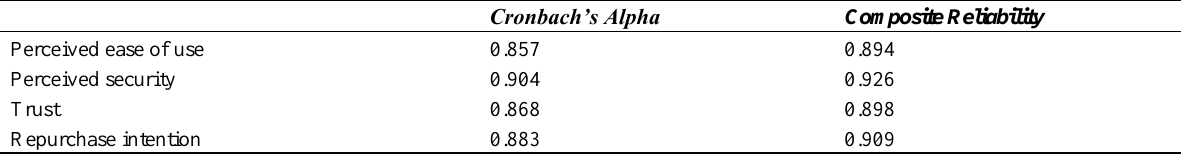
Table 4: Reliability Analysis